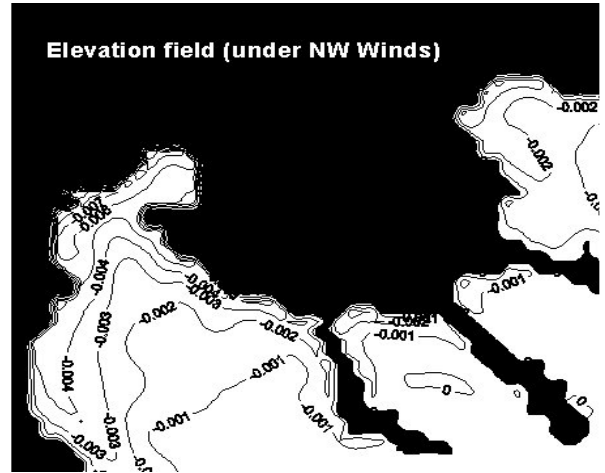
Fig. 6. Depth average currents from the model runs due to NW winds (19 September 2002).